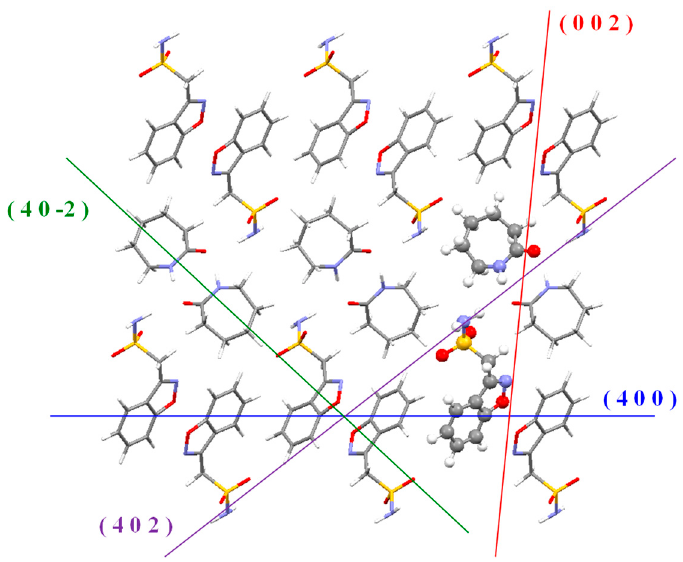
Figure 3. Relevant lattice planes (hkl). Asymmetric unit is shown in ball-and-sticks representation.